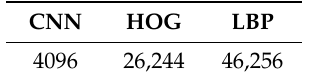
Table 3. Size of feature vector per image.